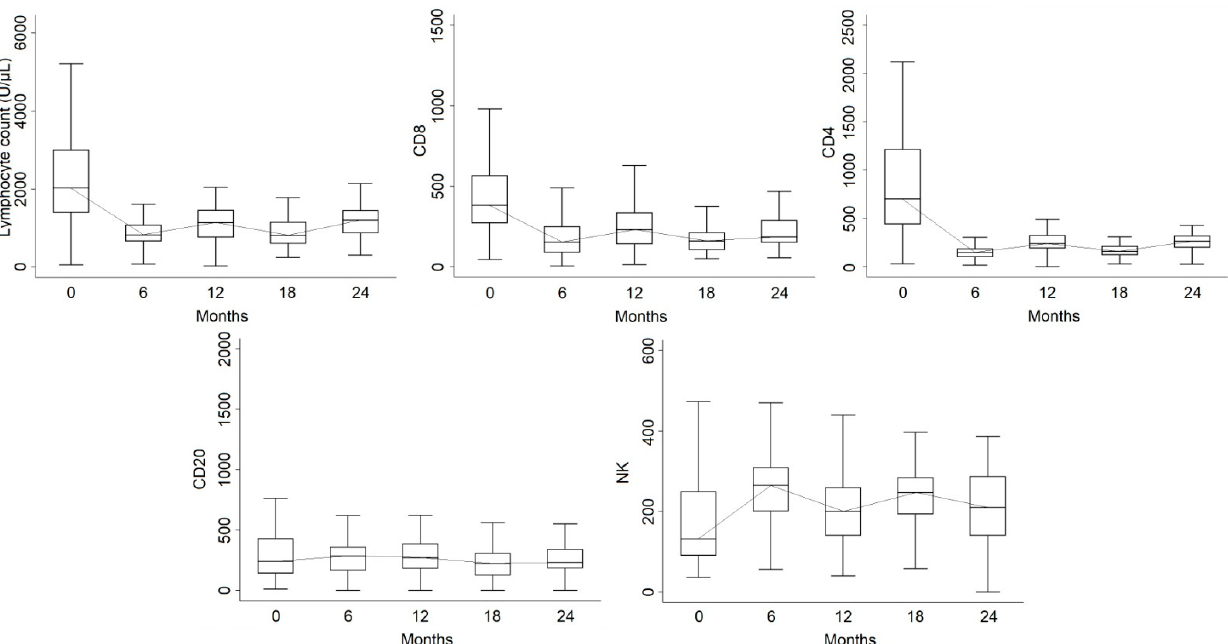
Figure 2. Boxplot of lymphocyte subset longitudinal trends over 24 months. The line represents the longitudinal trend of the median value for each subset reported.